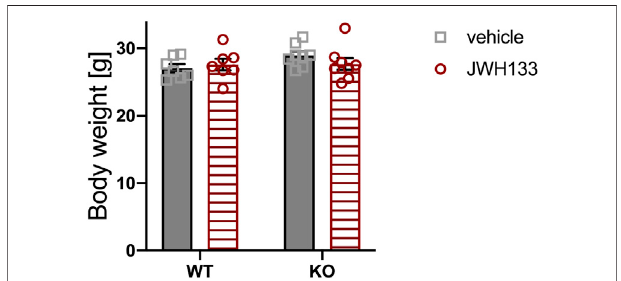
FIGURE1| Bodyweight ofp62KO and WTlittermatesisnot differentat the age of 3 months. Male mice were aged 3 months at the beginning of the experiment and were treated for 5 days with vehicle or JWH133. Body weight ofmicewassimilarbetweenallexperimentalgroups.Datawereanalyzed byusingordinarytwo-wayANOVA.Allerrorbarsshowmean±SEM.Squares and circles represent individual data points. WT vehicle N = 7, KO vehicle N = 8, WT JWH133 N = 8, KO JWH133 N =